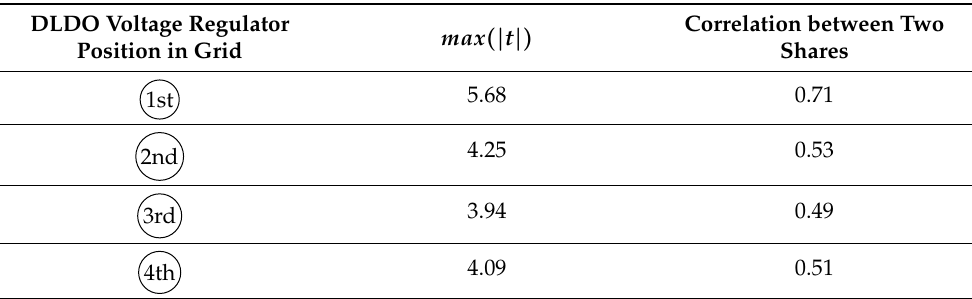
Table 3. The t -test results of the power delivery grid network with different locations of the DLDO voltage